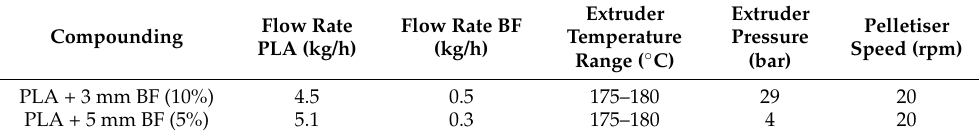
Table 3. Compounding extrusion process parameters for the preliminary tests. Compounding